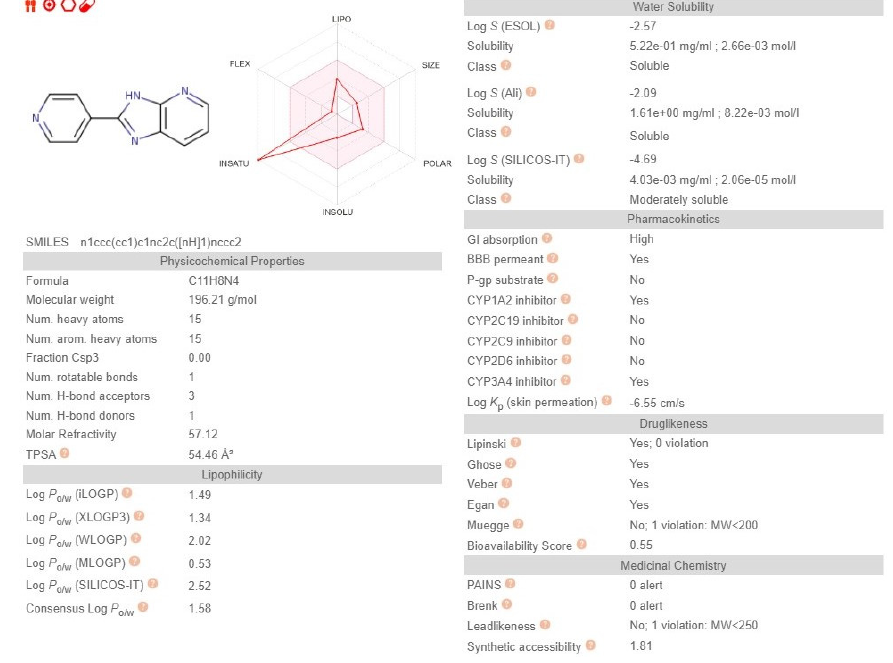
Figure 8. ADME for L1 .